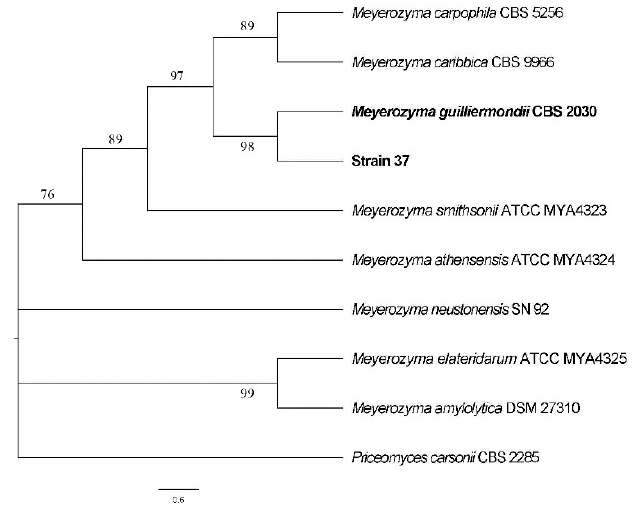
Figure 2. Phylogenetic tree of ITS sequence of strain 37.